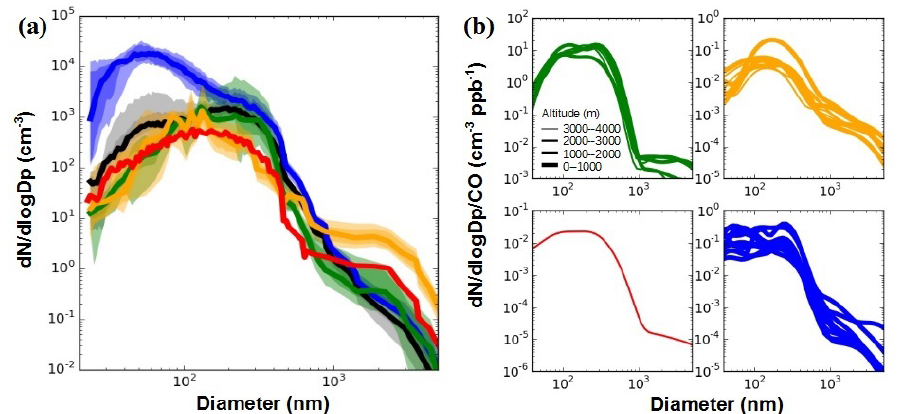
Figure 5. (a) Statistical analysis of number size distributions with coloured areas representing the 3rd, 25th, 75th and 97th percentiles of the data and (b) number size distributions normalized to CO for plumes dominated by biomass burning (green), dust (orange), mixed dust– biomass burning (red), anthropogenic pollution (blue) and background particles (black). In panel (b) , the line thickness is scaled by the altitude of the aerosol